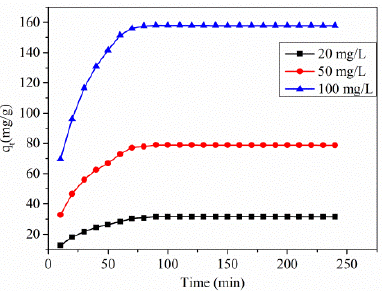
Figure 6. Effect of contact time on the adsorption capacity of Cu(I)-PANI composite (different initial concentration, pH, dosage, contact time, and volume of solution are 20–100 mg/L, 4, 0.06 g/L, 240 min, and 100 mL, respectively).